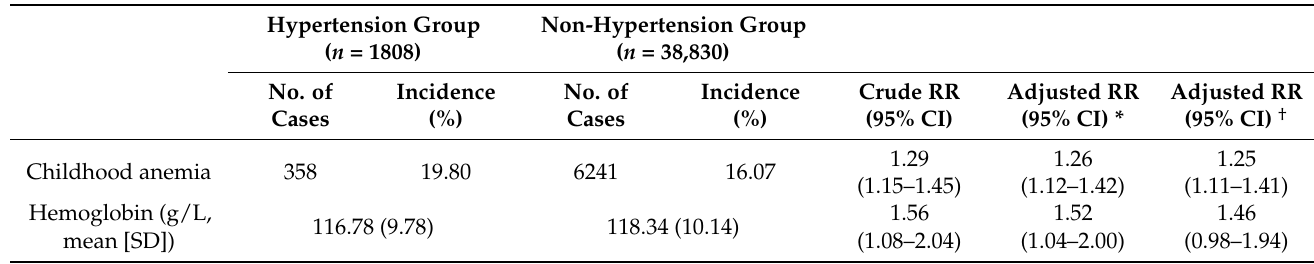
Table 2. Associations of childhood anemia incidence and hemoglobin level (g/L) with preconception hypertension in